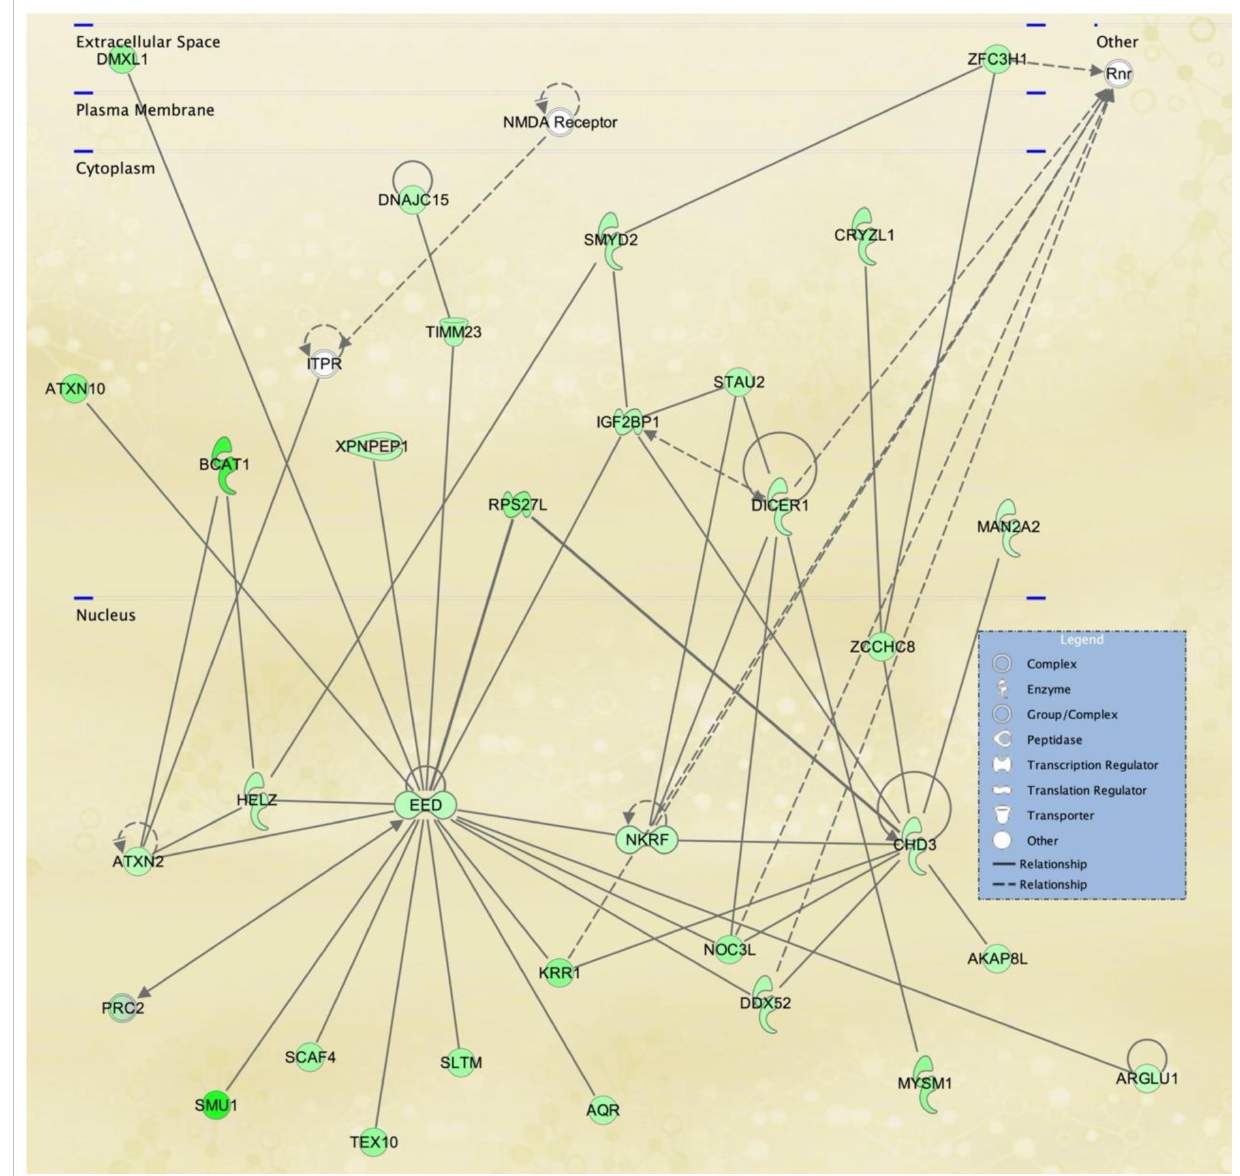
Figure 8. Cancer, organismal injury and abnormalities, RNA post-transcriptional modification network affected in lym- phoblastoid cells derived from an SS patient. IPA Network 9 is centered on the EED gene, which encodes a member of the Polycomb-group (PcG) family, involved in maintaining the transcriptional repressive state of genes over successive cell generations through histone deacetylation. This gene network is essentially repressed in the LCL deficient in TWIST2 activity used in this